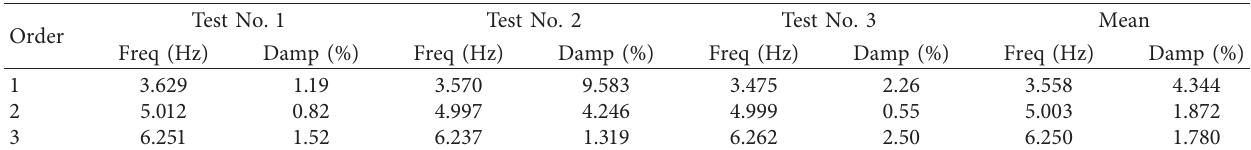
Figure 5: The stability of test No. 1. The red line represents the location of the identified frequencies. (a)The stability diagram of the first set of data. (b) The stability graph of the second set of data. Table 1: Modal frequencies and damping of the first three orders of the reinforced wall.